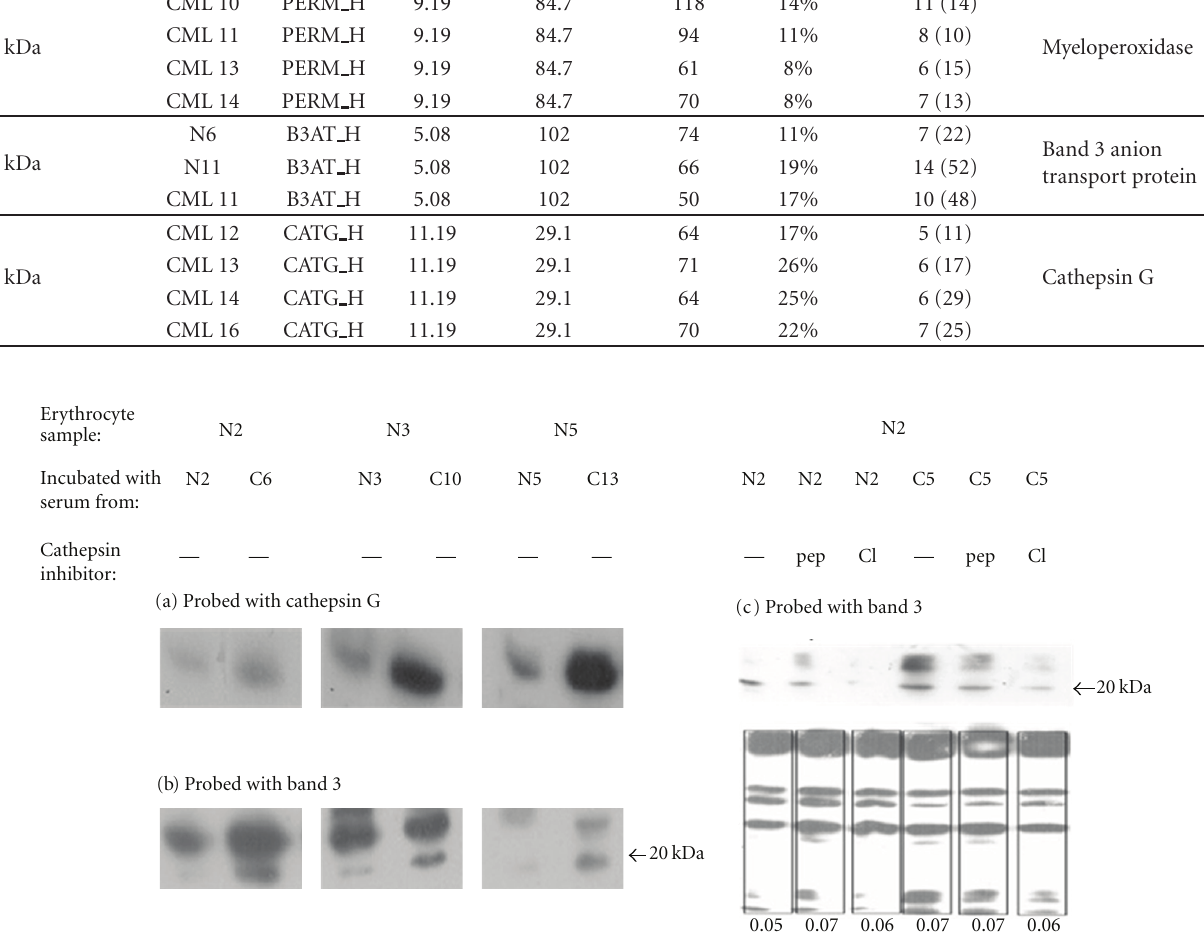
Figure 3: In vitro studies to delineate the role of cathepsin G in the proteolysis of band 3. Heat-stressed normal (N) erythrocytes were incubated with IgG-depleted/complement-inactivated sera from the same individual and also with sera from CML patients designated C (N2 with C6, N3 with C10 and N5 with C13) at 37 ◦ C for 20 min. Western blots prepared from the lysates of these erythrocytes were stained with cathepsin G and band 3 antibodies. (a) Cathepsin G levels are higher in the membrane of erythrocytes incubated with CML sera as compared to normal sera. (b) Staining of the same blot with anti-band 3 antibody shows that a 20 kDa fragment of band 3 is seen in cells incubated with CML sera. (c) The generation of 20kDa fragment is diminished upon incubation with pepstatin A (pep) and is nearly inhibited by cathepsin G inhibitor 1 (CI). Densitometric readings of each lane of the band 3 autograph corresponding to the lanes in (c) demonstrate equal